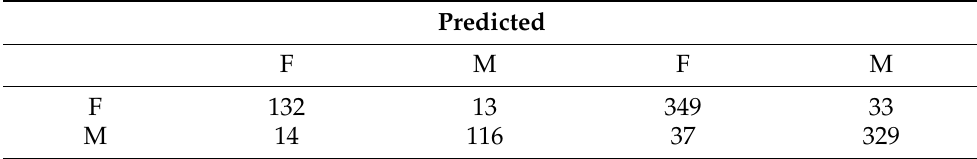
Table 3. Confusion matrix representing the gender identification. The first part of matrix represents the identification in terms of number of subjects; whereas the second part explores the prediction in terms of images per one camera. F: Female, M: